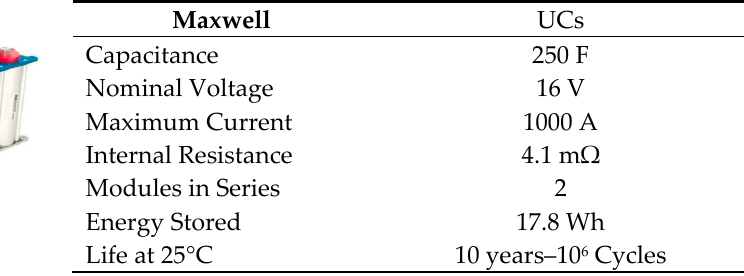
Figure 4. BMOD0500 P016 B02 modules specification.